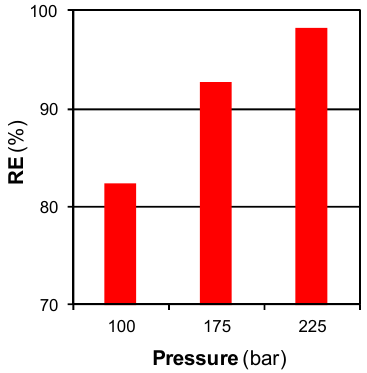
Figure 8. Effect of pressure on RE for SCCO 2 regeneration at 200 °C with a SCCO 2 flow of 3 cm 3 ·min − 1 during 15 min.